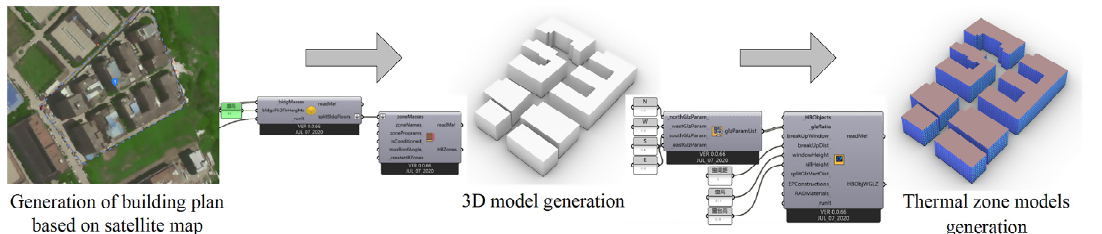
Figure 8. The process of 3D model generation.